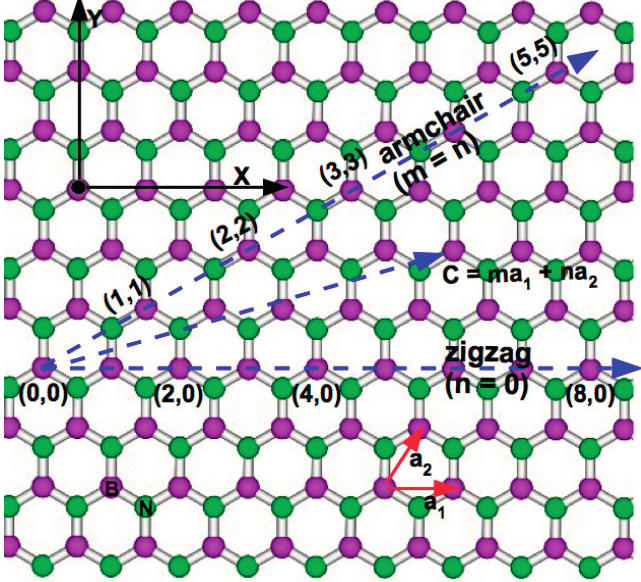
Figure 1. The chiral or the circumferential vector ( C ) in terms of two unit vectors a describes how to roll up the 2D hexagonal BN sheet to form a BN nanotube. The chiral indices (m, n) denote the number of unit vectors along two directions in the honeycomb 2D hexagonal BN lattice. When n = 0, the NT is referred to as the zigzag NT and when n = m, the NT is referred to as the armchair